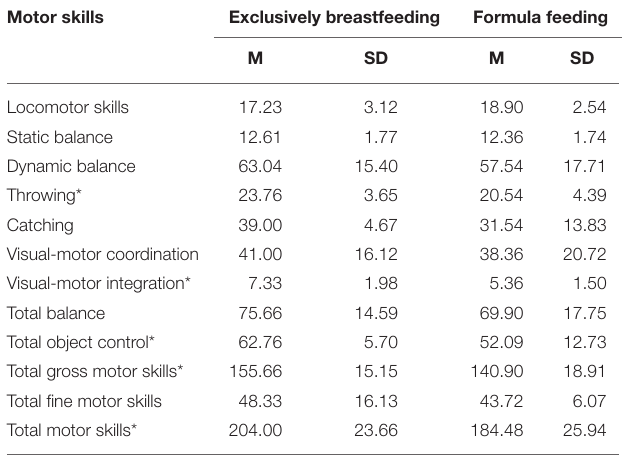
TABLE 2 | Means (M) and Standard Deviations (SD) of motor skill scores based on delivery mode. Motor skills